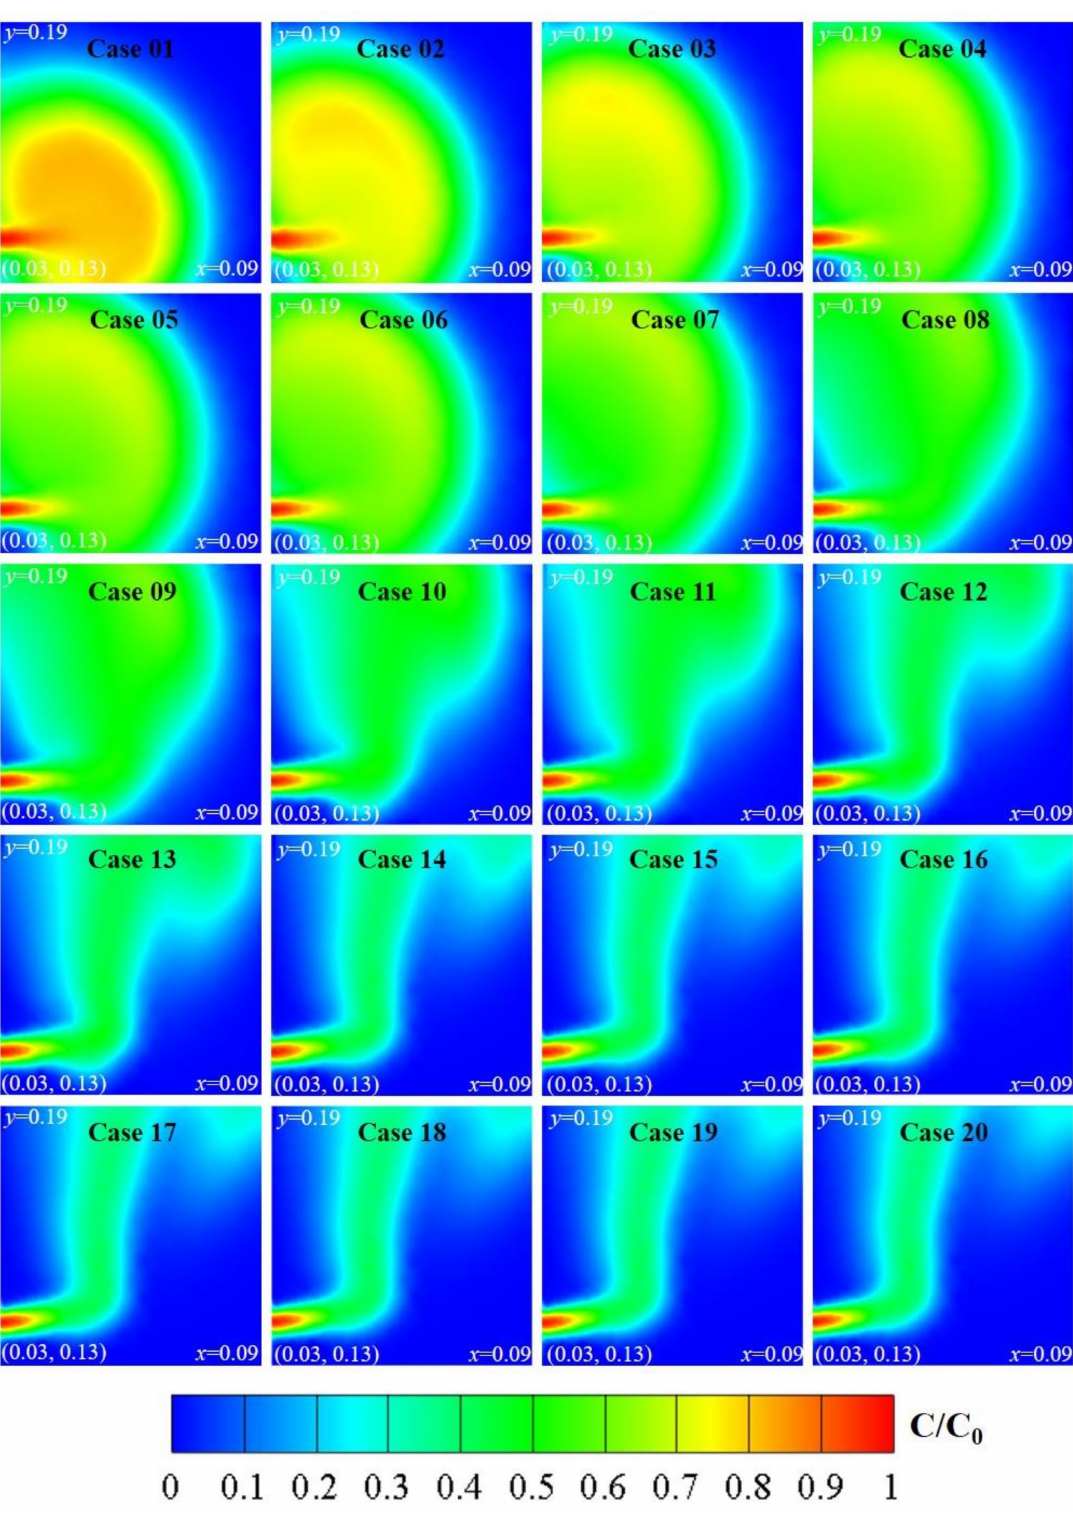
In the dataset, the mean, minimum, maximum, and median values for Fr were 9.993, 5.305, 24.676, and 8.022, respectively. The standard deviation, variance, kurtosis,